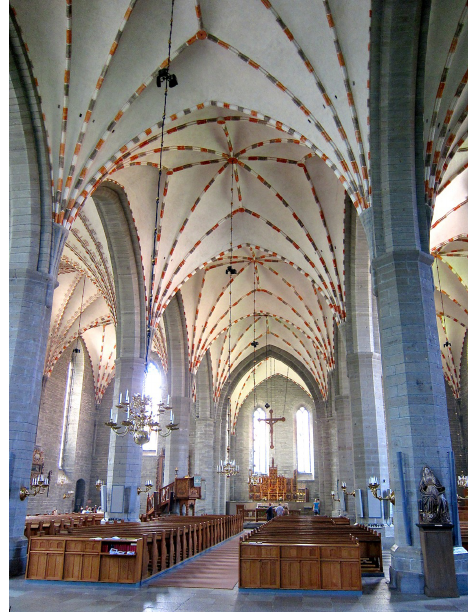
Figure 1. Present day church. View from east to